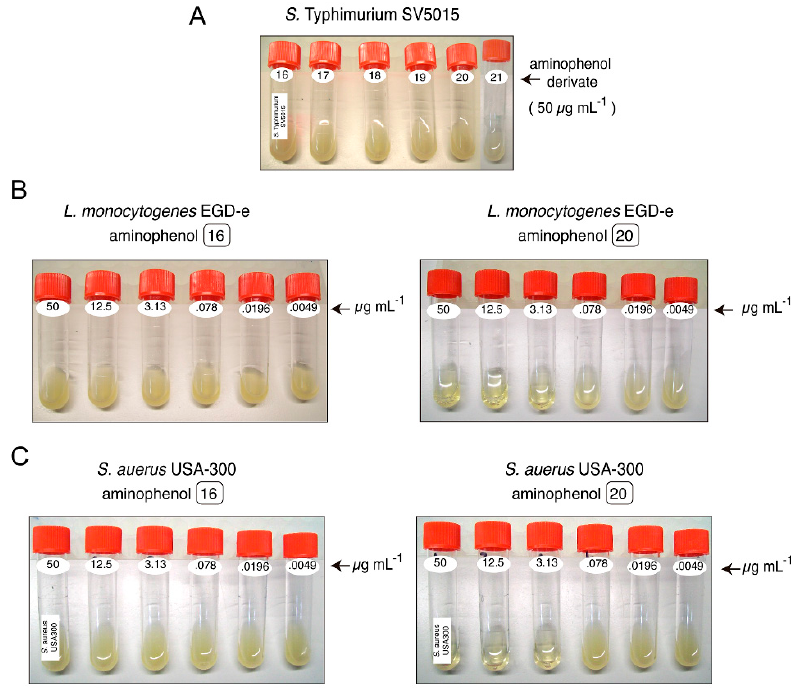
Figure 2. Antimicrobial assays in liquid culture using different aminophenol compounds and bacterial species. Bacteria were cultured in media containing the aminophenol for 18 h overnight culture. ( A ) Lack of effect of the test compounds (50 µ g mL − 1 ) in the Gram-negative bacterial pathogen S. Typhimurium strain SV5015; ( B ) Differential effect of aminophenol compounds 16 and 20 in